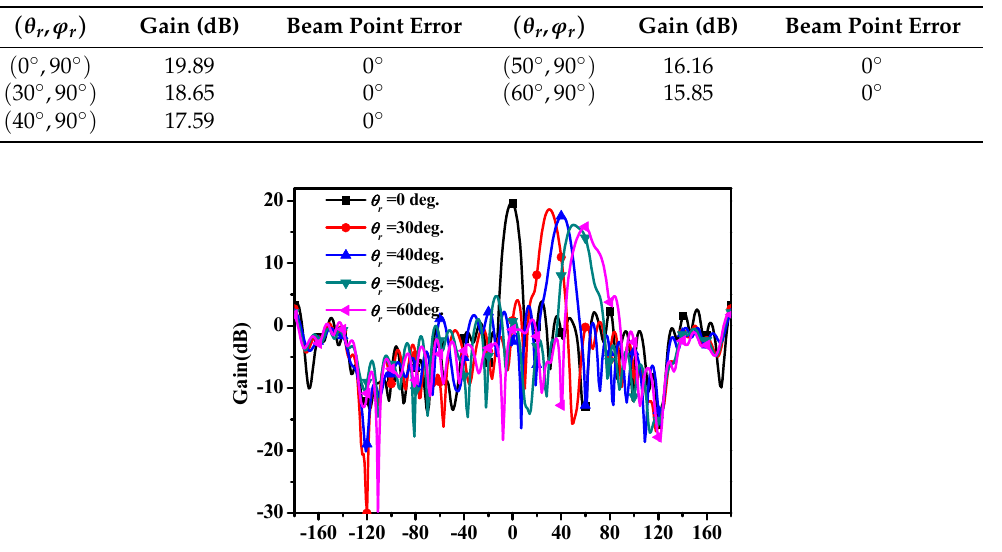
Table 2. The gain of the 1-bit digital RRM at different main beam directions and beam point errors for different scanning angles.